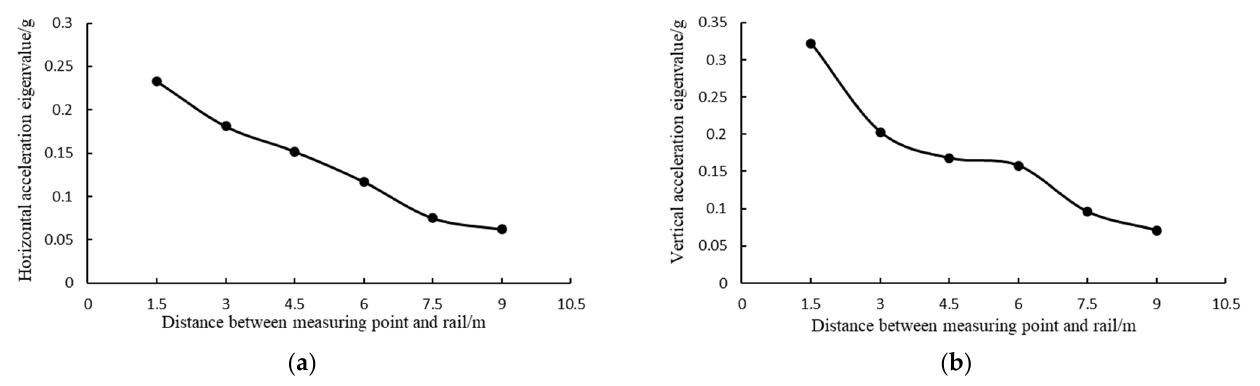
Figure 13. Simulation results of acceleration of east exhaust inclined shaft. ( a ) Simulation results of horizontal acceleration of east exhaust inclined shaft; ( b ) simulation results of vertical acceleration of east exhaust inclined shaft.